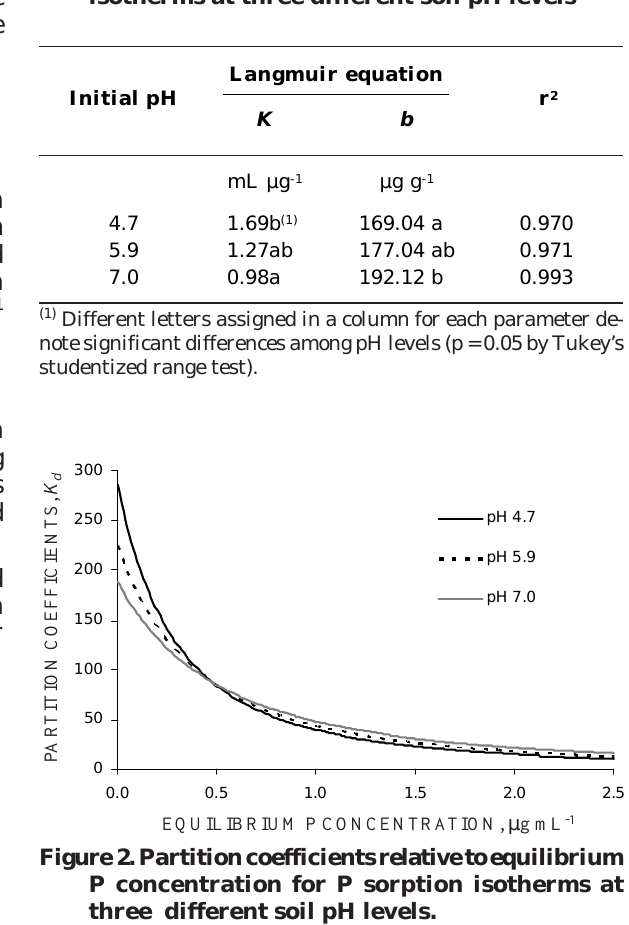
Table 2. Langmuir parameters for P sorption isotherms at three different soil pH